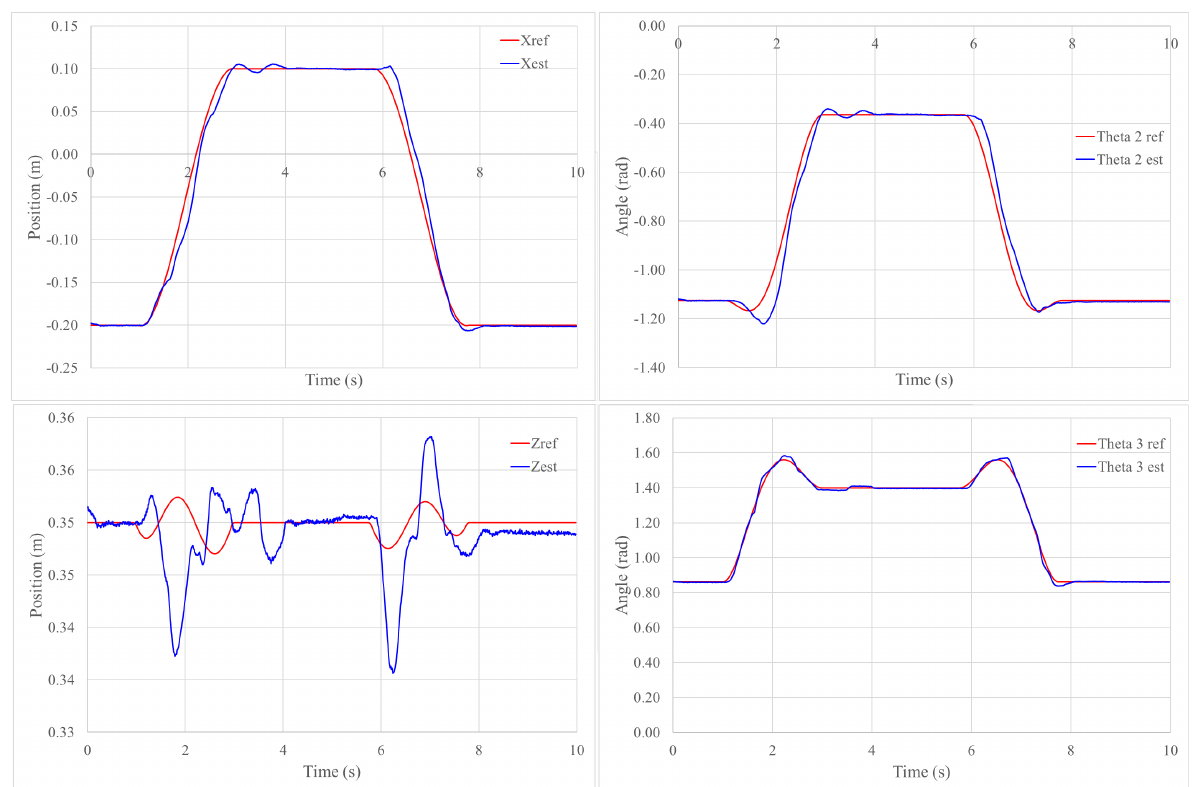
Figure 18. Trajectory Following Results—Test Set